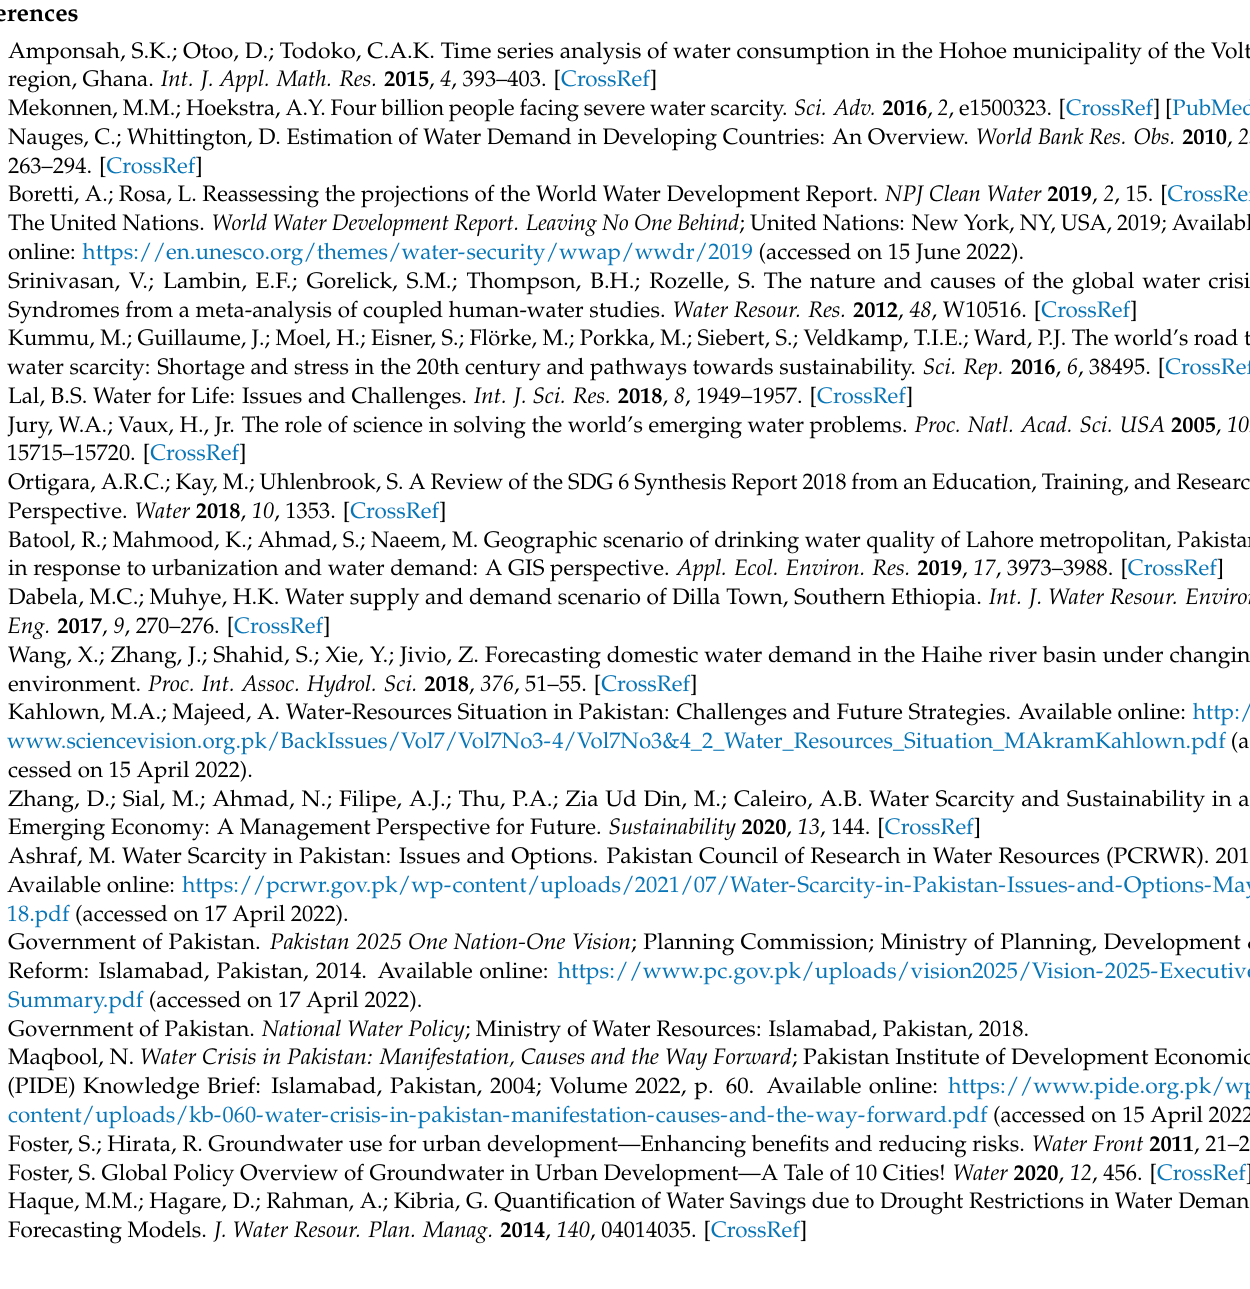
Figure A2. Monthly variation of metered consumption and ambient temperature in Tajpura.